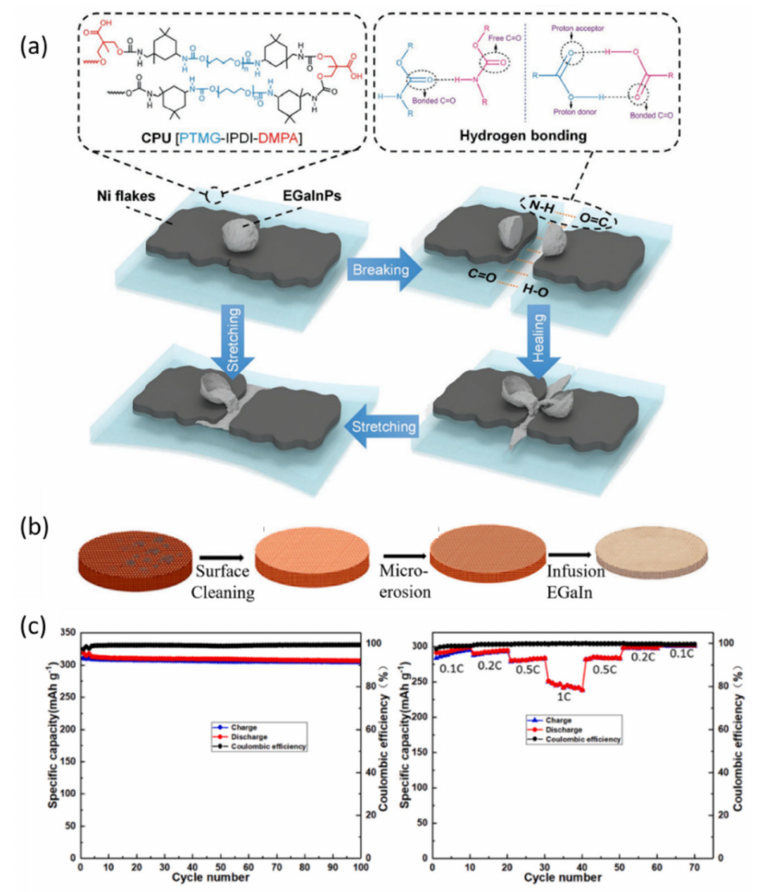
Figure 8. ( a ) Schematics of the mechanism for the self-healing property of the Ni flakes–EGaInPs– CPU conductor [18]. Copyright 2018, John Wiley and Sons. ( b ) schematic of the fabrication process of EGaIn@3D-Cu current collector and ( c ) cycling and rate performances of the self-healing graphite anode with scratch damage at 0.2 C [97]. Copyright 2021, Elsevier